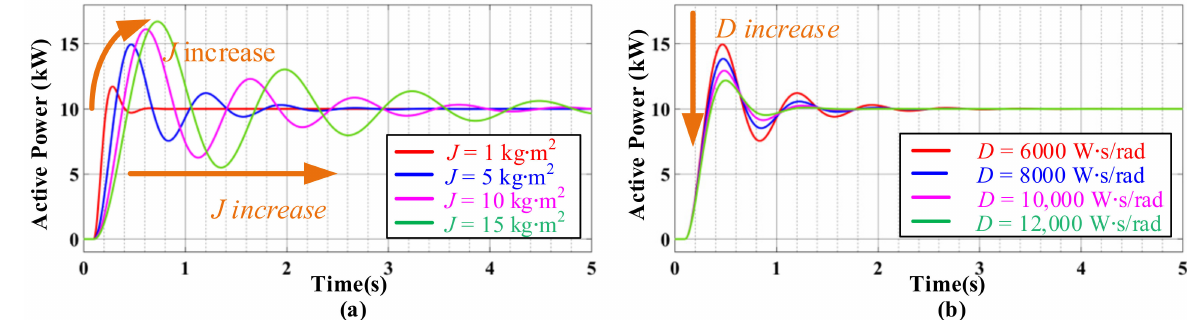
Figure 6. Power response curves under different J and D. ( a ) different J ( b ) different D .